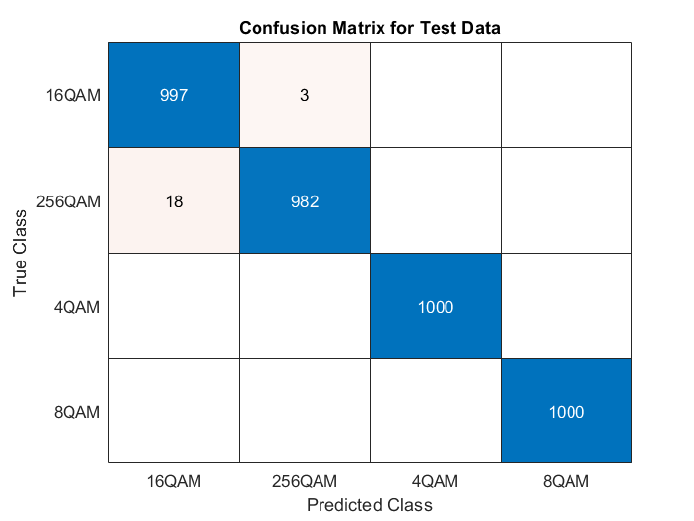
Figure 6. Confusion Matrix for Case-II at SNR = 10